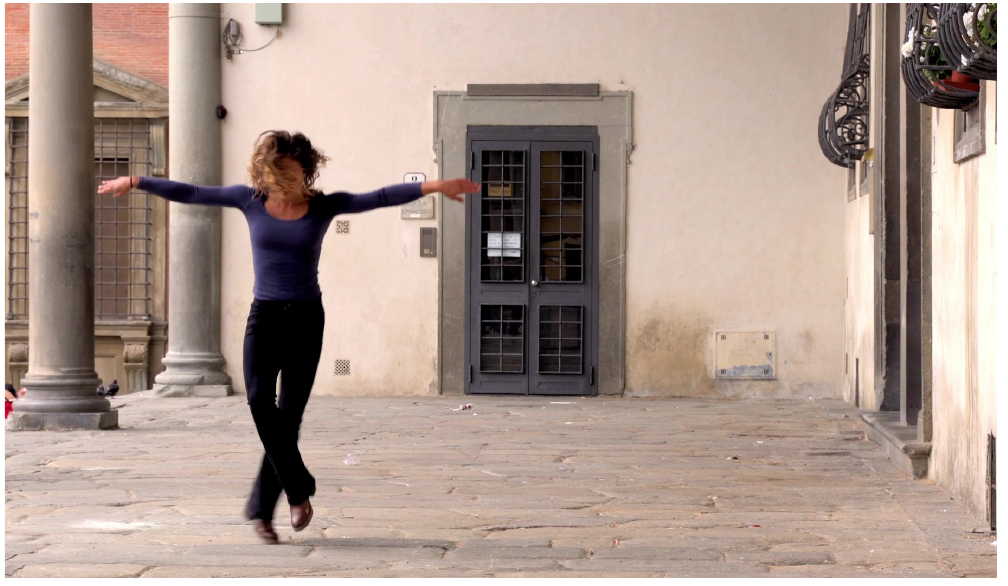
Fig. 8 The Dancer, Carolina